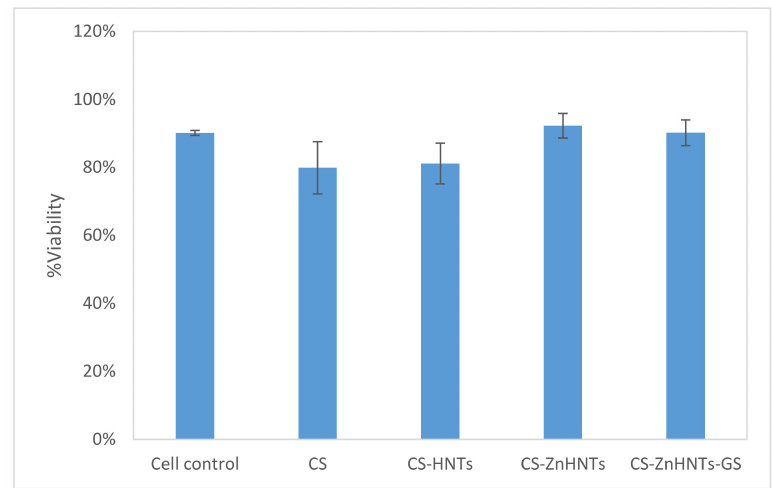
Figure 14. Cell viability assay for Ti foil sca ff olds; the CS-ZnHNTs coating had the highest cell viability